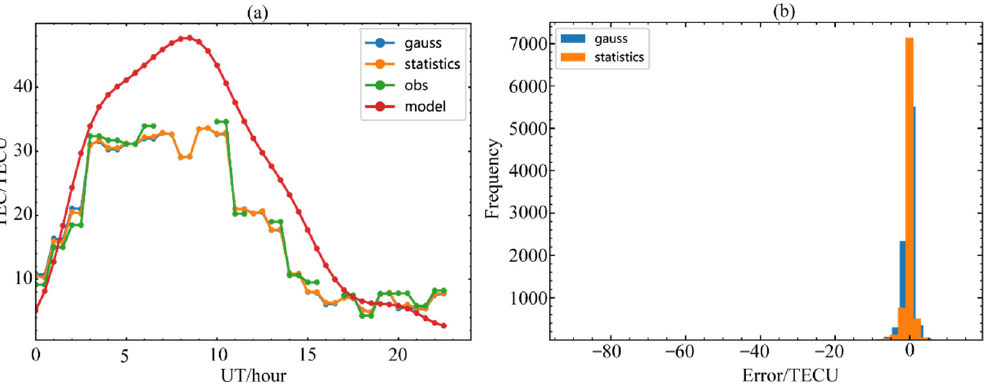
Figure 5. The comparison of TEC by different covariance modeling methods. ( a ) The comparison curve of TEC for different covariance modeling methods, observed and modeled in one day at 25°N, 90°E; ( b ) The TEC error statistical results of different modeling methods in one